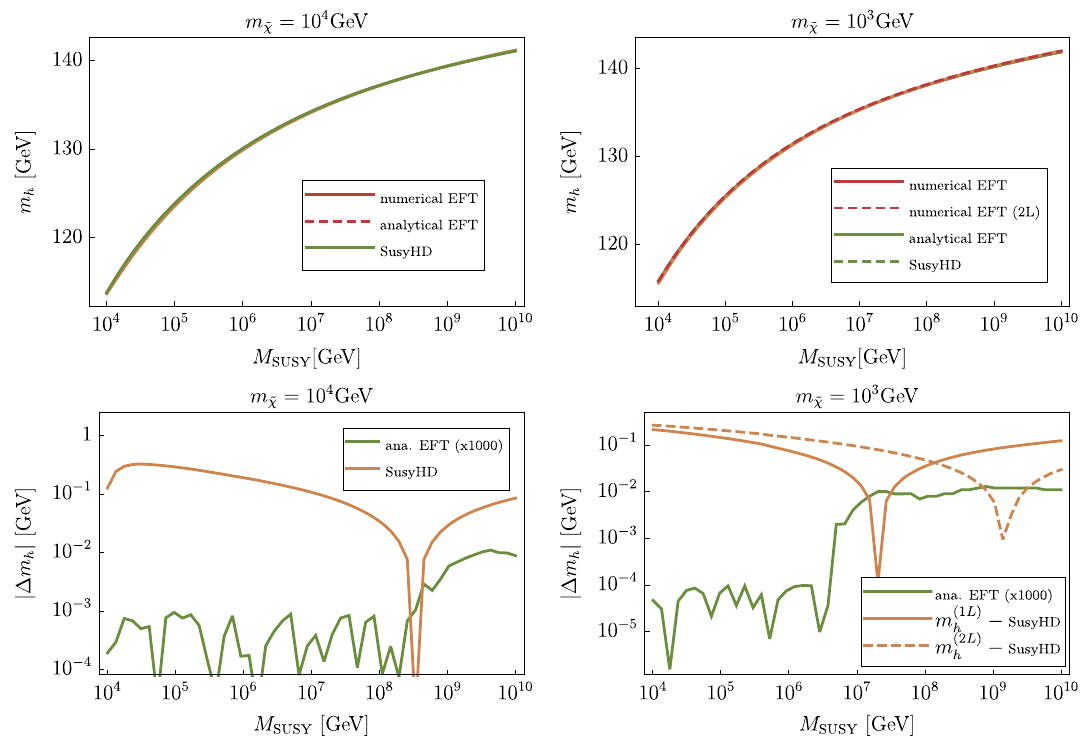
Fig. 8 Prediction for the SM Higgs boson mass m h in split-SUSY as function of M SUSY , which is the mass scale of all SUSY scalars, and for two different values of M χ , which is the mass scale of all SUSY fermions. Inaddition, weusedhere tan β = 3. The blueandpurple lines show the results of SPheno using the analytical or numerical approach to obtain the matching conditions at M SUSY , while the green line cor-